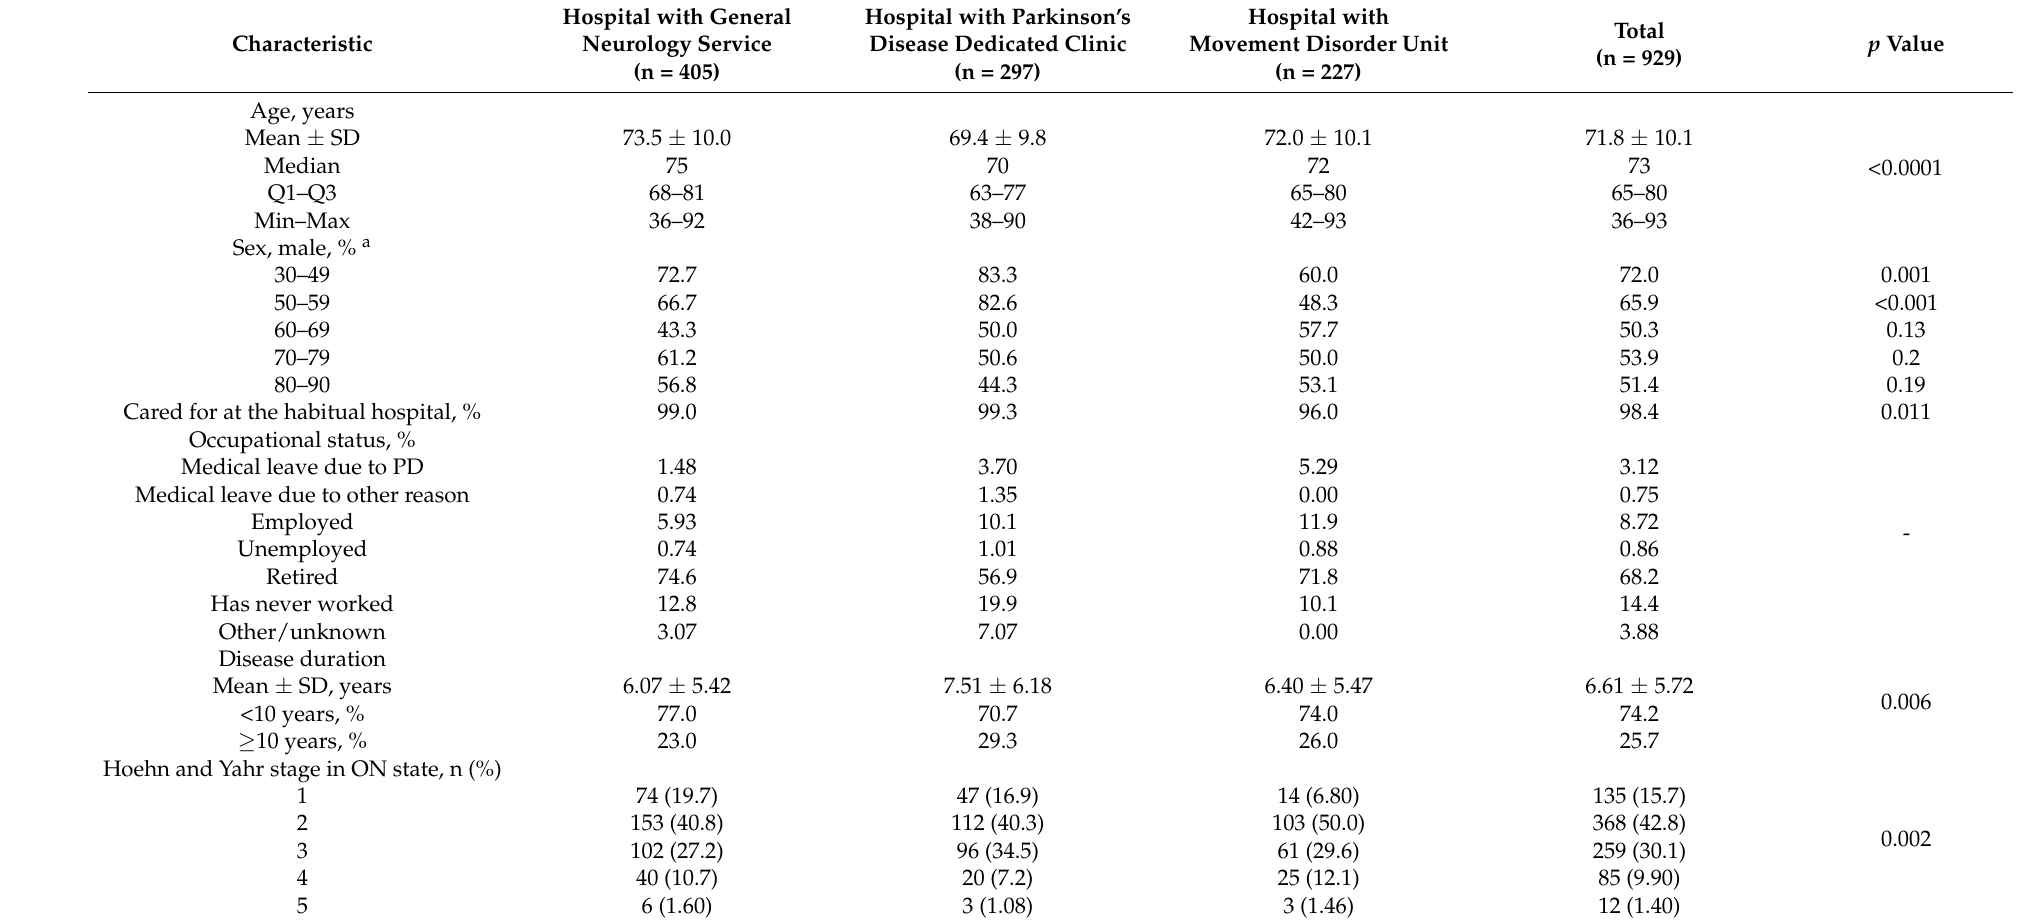
Table 1. Clinical and sociodemographic characteristics of patients at the time of study inclusion according hospital